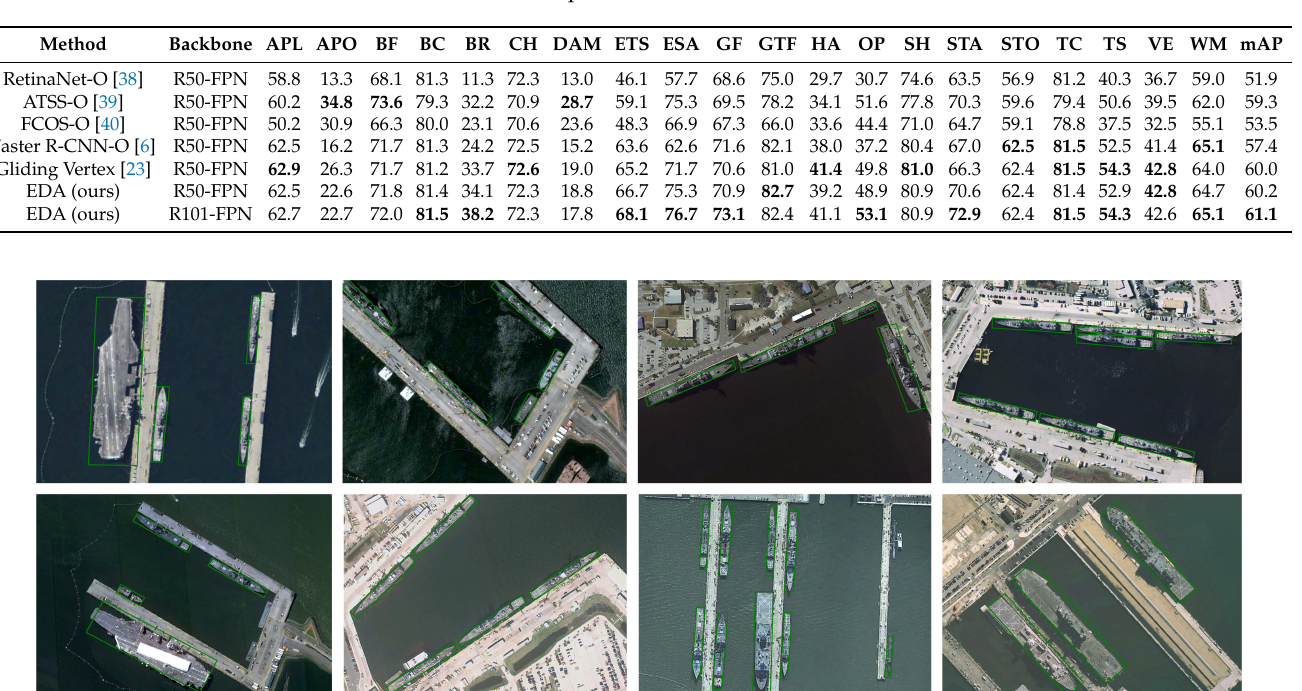
Table 4. Quantitative comparisons on DIOR-R.